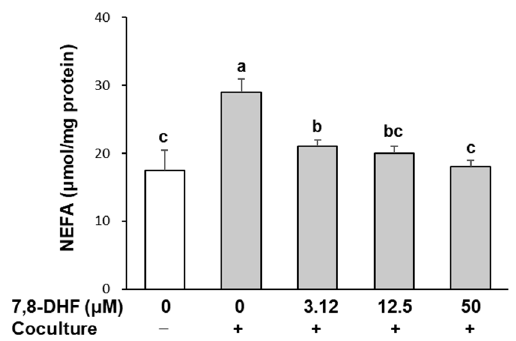
Figure 3. Effect of 7,8-DHF on free fatty acid release in coculture of adipocytes and macrophages. Hypertrophied 3T3-L1 adipocytes were cocultured with RAW 264.7 macrophages for 24 h and then treated with 7,8-DHF for 24 h in the contact system. Concentration of NEFA in the coculture medium was measured by a NEFA kit. Values are mean ± SD of three independent experiments. Means without the same letters are significantly different by ANOVA, followed by Duncan’s test ( p < 0.001). +: adipocytes were cocultured with macrophages, − : adipocytes and macrophages were separately cultured and mixed before the assay. 7,8-DHF, 7,8-dihydroxyflavone; NEFA, non-esterified fatty acid.